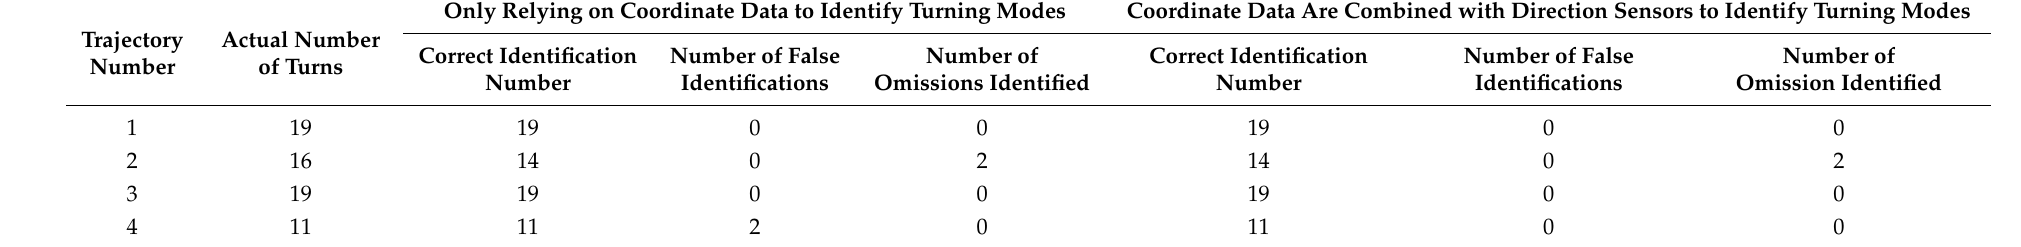
Table 5. Recognition accuracy of turning modes when the compression threshold is set to 10 m.